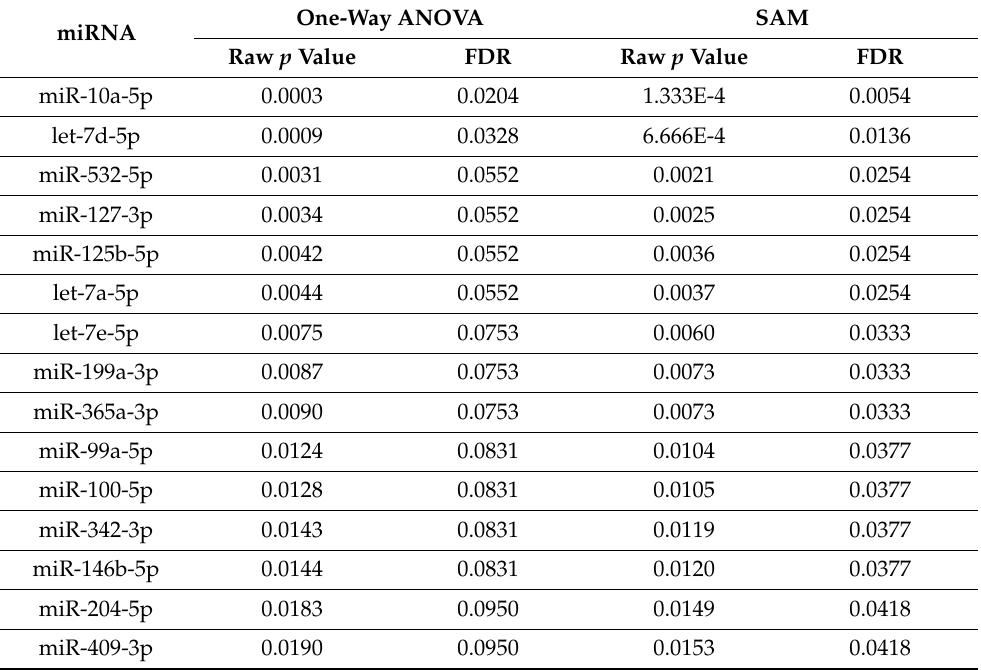
Table S4). Regarding anthropometric parameters, no significant correlations with WHR and BMI were found. Table 3. Significantly changed miRNAs indicated for intergroup comparisons (T2DM, IFG, NG) by one-way ANOVA and SAM for female subjects (N = 26) with FDR < 0.1 for both analyses. SAM results were generated by Metaboanalyst